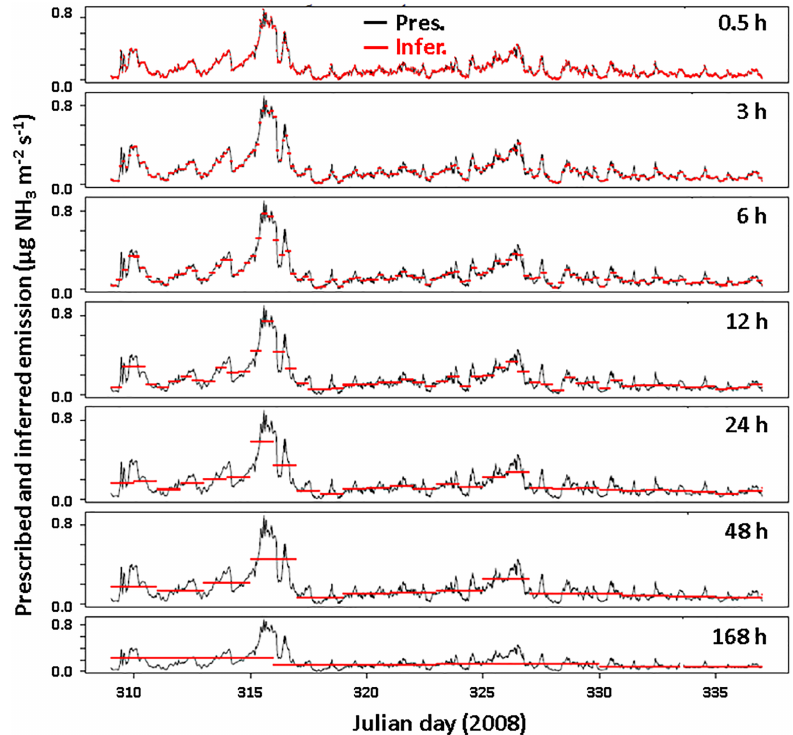
Figure 5. Example source inference for a 25m width square field and a concentration sensor placed at 0.5m above ground. Here (cid:48) = 10 5 and is set to constant (pattern 1). The seven integration periods are shown: 0.5 to 168h. The x axis shows the day of year and corresponds to a span over November. The prescribed source is in black (Obs.) and the inferred one in red (Pred.).